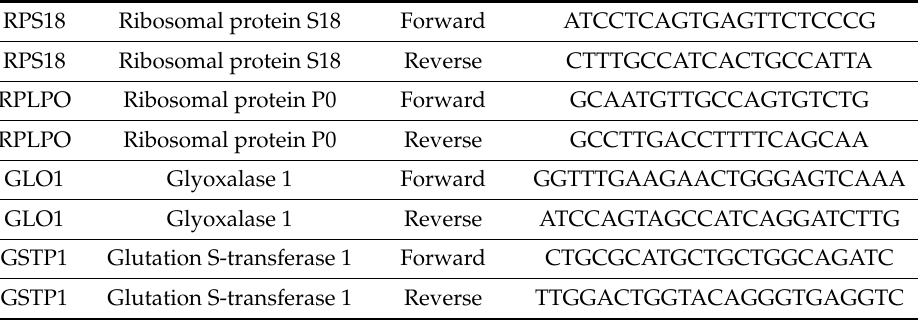
Table A1. Primers used for